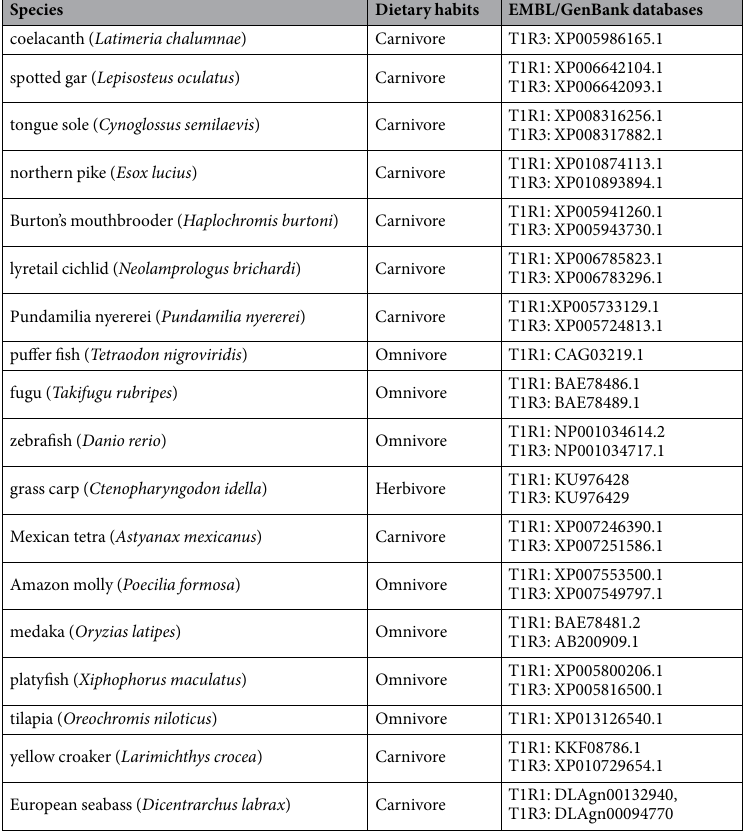
Table 3. Food habit information for the fish studied. Sources of information: http://animaldiversity.ummz. nearby T1R1. ER membrane protein complex subunit 1 (EMC1) and ubiquitin protein ligase E3 component n-recognin 4 (UBR4) appeared on the downstream of T1R1 in medaka, fugu and tongue sole; however, it was located on the upstream of T1R1 in zebrafish and grass carp. The upstream genes of T1R1 in grass carp were sim- ilar to those in zebrafish. Regulation of nuclear pre-mRNA domain containing 1B (RPRD1B) gene was present on the upstream of T1R1 in medaka, fugu and tongue sole, but not in zebrafish and grass carp. In the fish we analyzed, the adjacent genes of T1R3 were partially conserved. The solute carrier family 45 member 1 (SLC45A1), prothymosin alpha-like (ProT α ), and coiled-coil domain containing 114 (CCDC114) genes were located on the upstream of T1R3 in most fishes. The ERBB receptor feedback inhibitor 1 (ERRFI1) gene was always next to T1R3 gene in fish, and the mitochondrial ribosomal protein S16 (MRPS16) and paired box 7a (PAX7a) genes were frequently on the downstream of T1R3 in fish (Fig. 6).